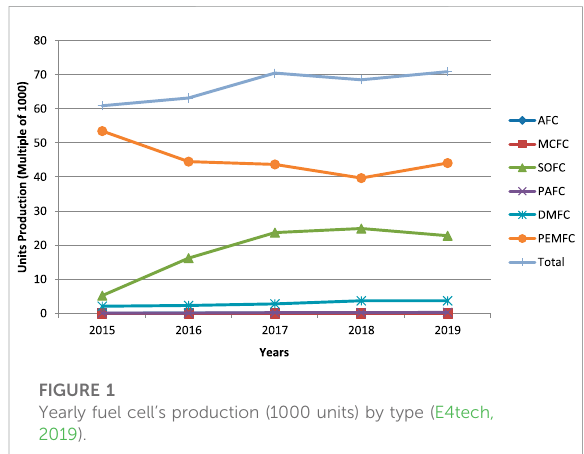
FIGURE 1 Yearly fuel cell ’ s production (1000 units) by type (E4tech, 2019).